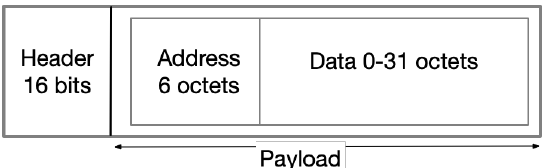
Figure 1. The PDU format of BT Mesh protocol.